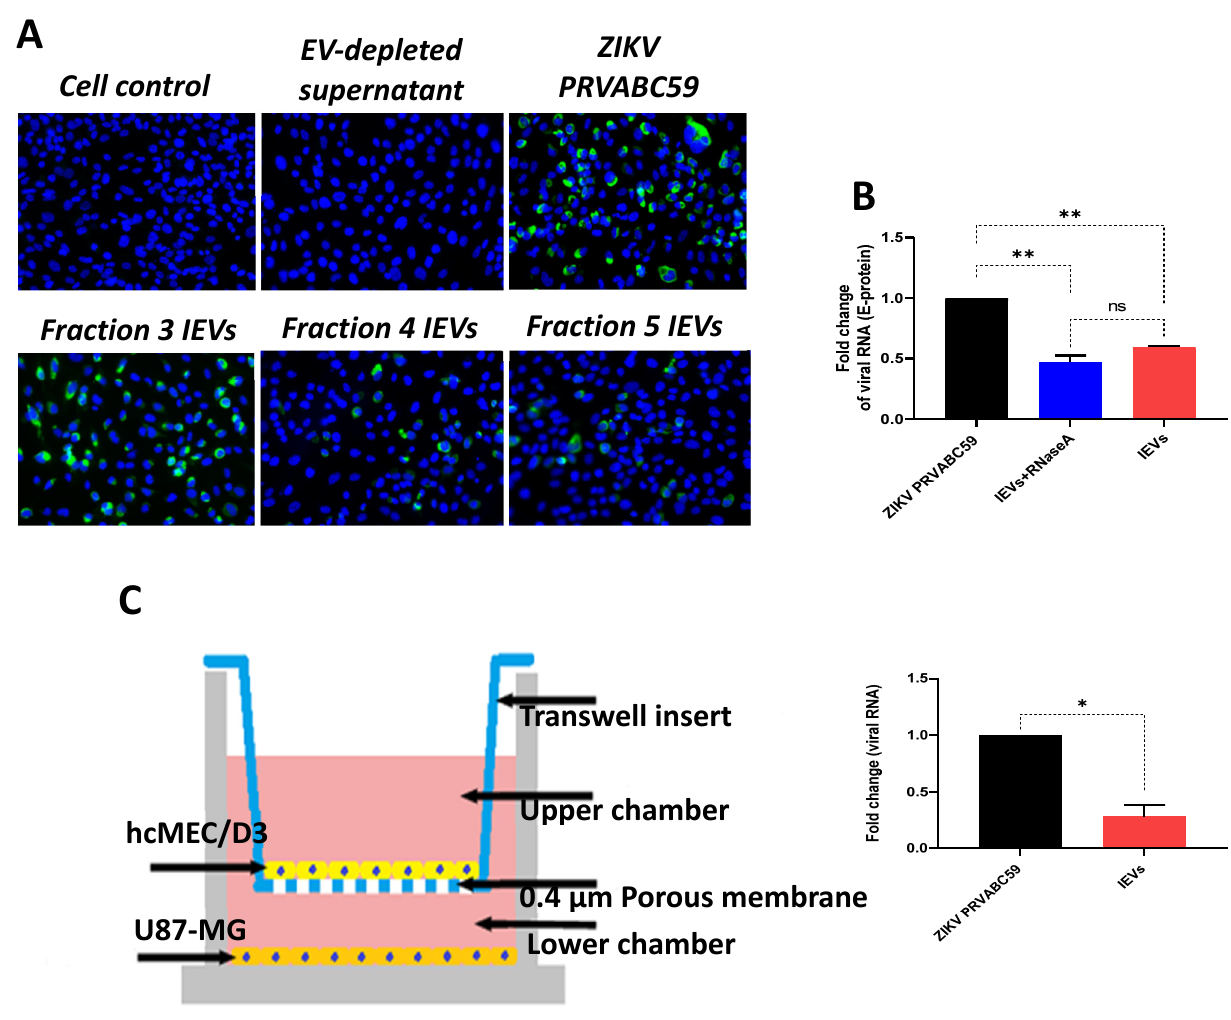
Figure 2. ZIKV-infected cell-derived EVs (IEVs) are able to transfer viral material to naïve cells. ( A ) Detection of ZIKV envelope protein (green) in hcMEC/D3 cells after their inoculation (72 h) with different IEV fractions (20× objective). Positive (ZIKV-infected cells) and negative (EV-depleted supernatant) controls are also included. ( B ) Fold change in viral RNA levels (detection of E-protein) among ZIKV- (black), IEVs-pretreated with RNase A (blue), and IEVs- (red) infected hcMEC/D3 cells. Pretreatment of IEVs with RNase A shows no differences in viral RNA levels with untreated IEVs, indicating that most of the RNA resides inside the vesicles. ( C ) Representation of the Transwell assay setup to demonstrate that IEVs (colored spheres), isolated from ZIKV-infected hcMEC/D3 cells, can transfer viral RNA to glioblastoma cells (U87-MG, lower chamber) (6 days post-infection). ZIKV virions (virus stock) was also included in the assay. Significant difference is also indicated between ZIKV- and IEV-treated cells and calculated based on p -values; ns: p > 0.05, * p < 0.05, ** p < 0.005. Data are acquired from two independent experiments.